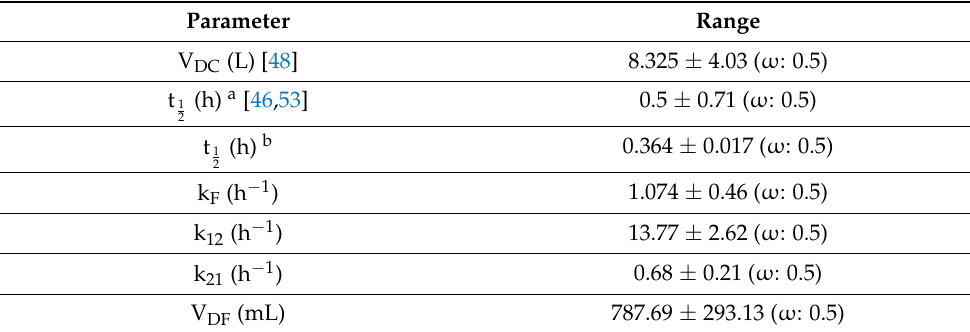
Table 7. Initial estimates used by the PBNB model for data analysis. Two simulations were carried with different initial estimates for the half-life (a and b). The second half-life as well as the pharma- cokinetic parameters of the free drug were obtained by pharmacokinetic analysis and not extracted from a literature